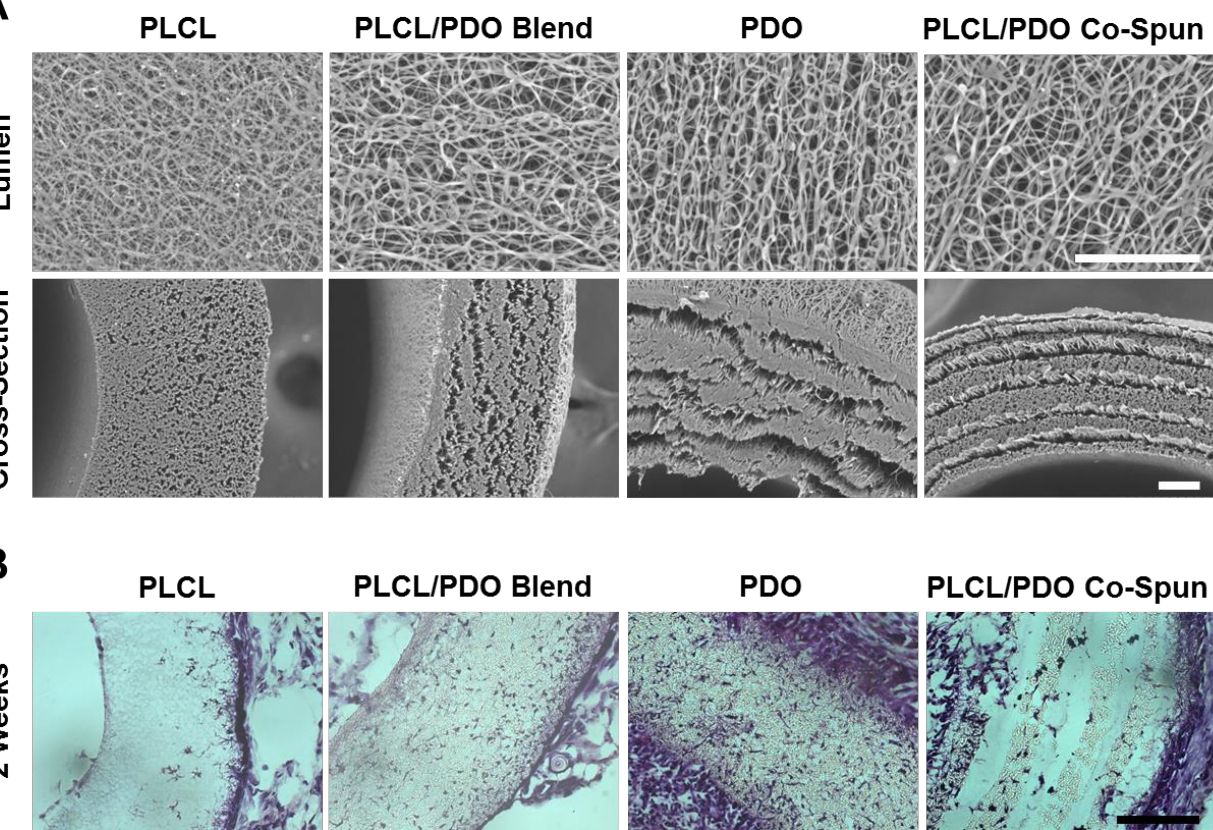
Figure 4. Characterization and in vivo cell infiltration of the single-layered microfibrous vascular grafts. ( A ) Luminal ( top ) and cross-section ( bottom ) surface of single-layered vascular grafts electrospun with 15% PLCL, PLCL/PDO blend, 20% PDO, and PLCL/PDO co-spun. Scale bar = 50 µ m. ( B ) H&E staining of single-layered vascular grafts electrospun with 15% PLCL, 20% PDO, PLCL/PDO blend, as well as vascular grafts co-electrospun with PLCL and PDO at 2 weeks after subcutaneous implantation. Scale Bar = 100 µ